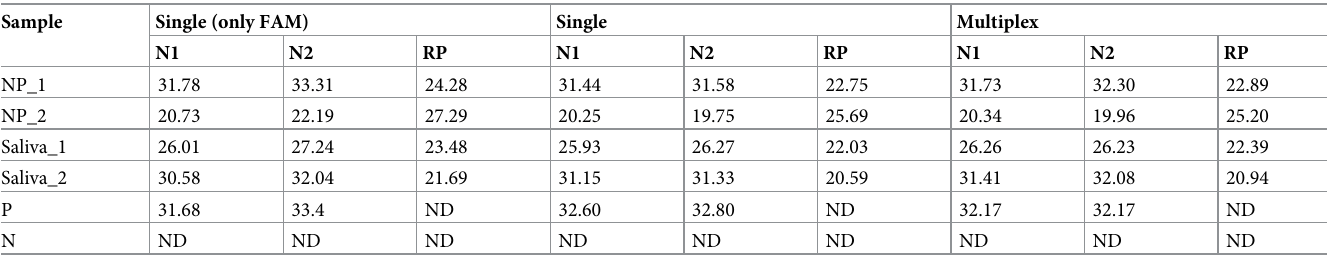
Table 2. Comparison of Ct values between single and multiplex RT-qPCR.